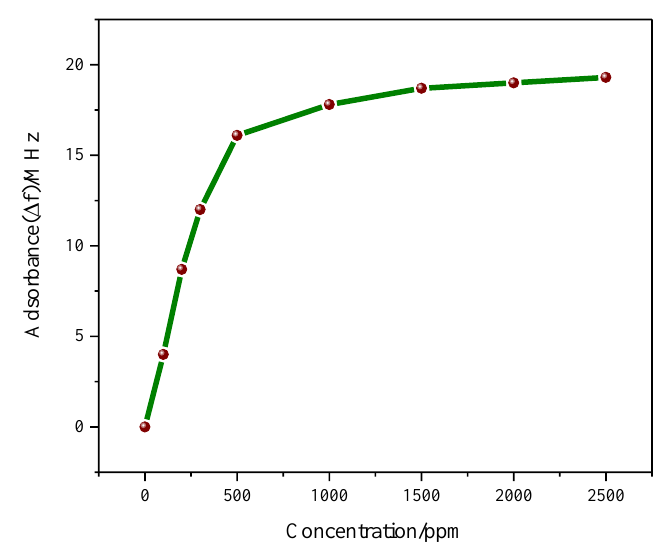
Figure 11. The relationship between ∆ f and concentration: In the range of 0 – 500 ppm, the change in resonant frequency shows a linear growth trend. When the concentration of NH 3 reaches 500 ppm or above, the change in resonant frequency remains basically same with any further increase in the concentration of NH 3 , indicating that when the concentration of NH 3 reaches a certain value, the ability of the sensor to adsorb NH 3 molecules reaches a steady state.